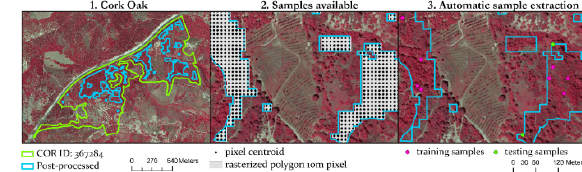
Figure 6 Automatic sample extraction from a COS polygon